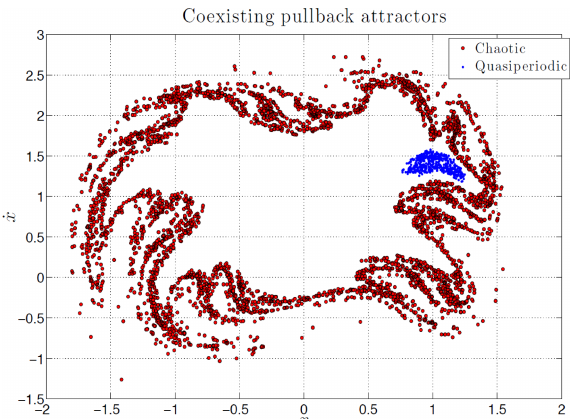
Figure A2. Coexistence of local PBAs. The initial data leading to quasiperiodic (and chaotic) orbits are taken from the small domain D 2 (and D 1 ) described by Eq. (A2). The snapshot of the PBAs shown here is taken at the fixed time t =